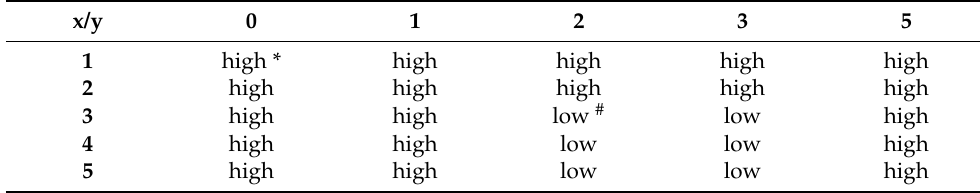
Table 2. State classification results.